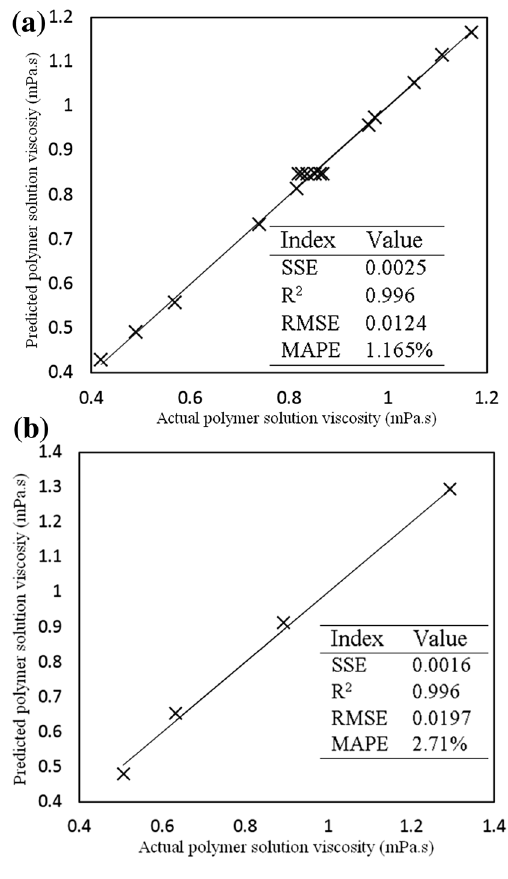
b Fig. 3 The influence of input parameters on the viscosity predicted by the RSM model with NaCl concentration held constant at 5 (g/L) ( a ), polymer concentration held constant at 3000 ppm ( b ) and with shear rate held constant at 10 s - 1 ( c )